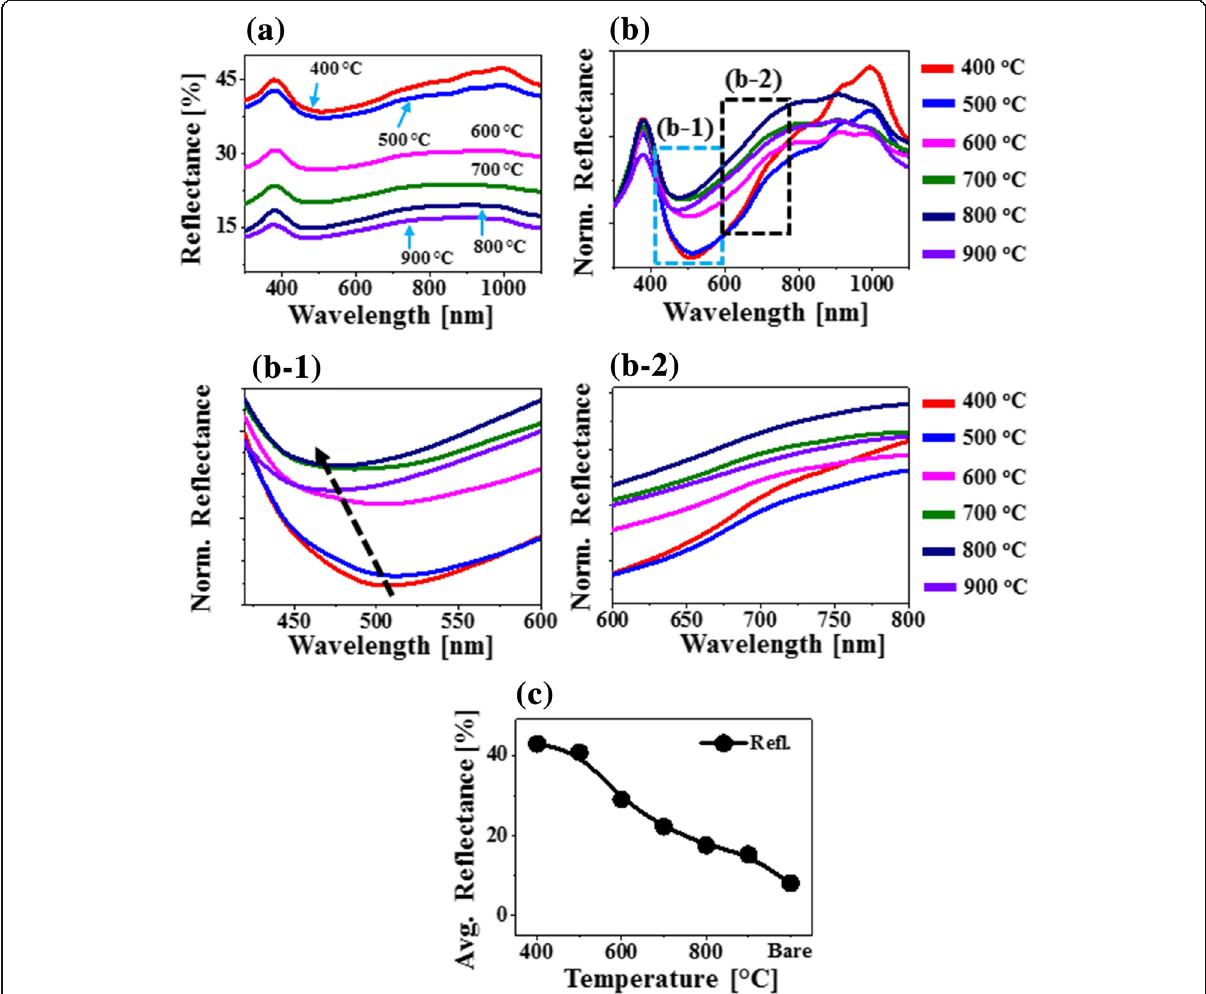
Fig. 3 Reflectance spectra of corresponging PdAuAg nanostructures annealed at various temperature between 400 and 900 °C tri-layers. a Reflectance spectra. b Plot of average reflectance as a funtion of annealing temperature. c Normalized reflectance spectra at 300 nm. c-1 – c-2 Magnified reflectance spectra at specific locations to show the shift of dips and shoulders: boxed areas in